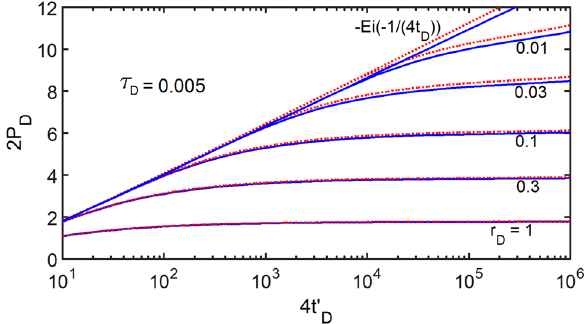
Fig. 6 Early radial to hemispherical flow transition, t � D